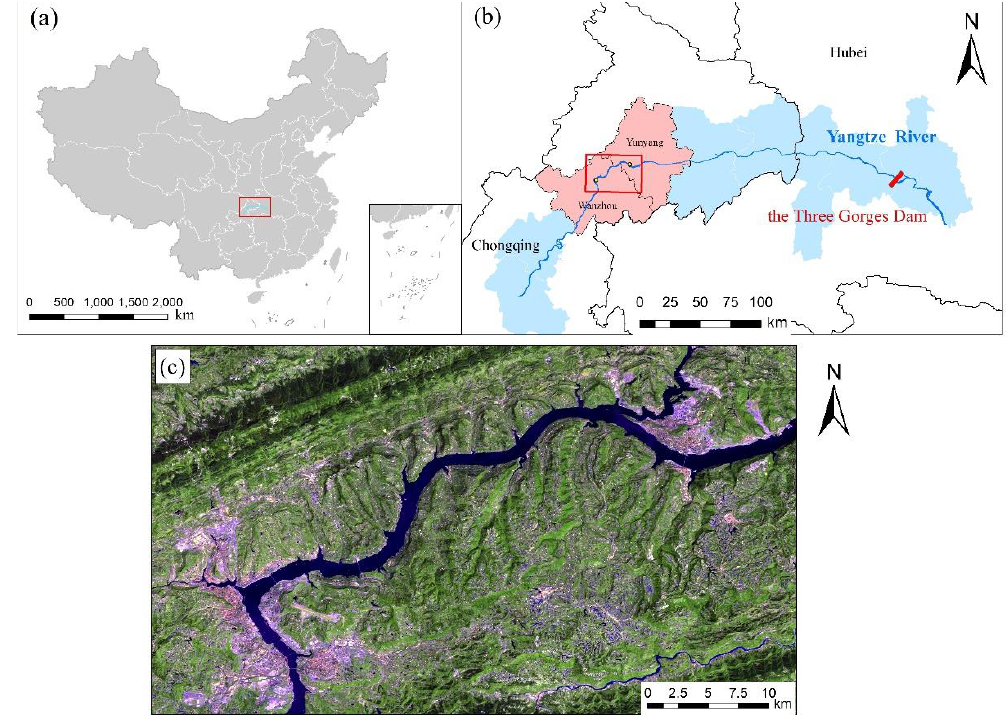
Figure 1. ( a ) Site map of the Three Gorges Reservoir Area (TGRA) in China. ( b ) Location of the study area in the TGRA. ( c ) A false color synthetic image showing the geographic coverage of the study area.